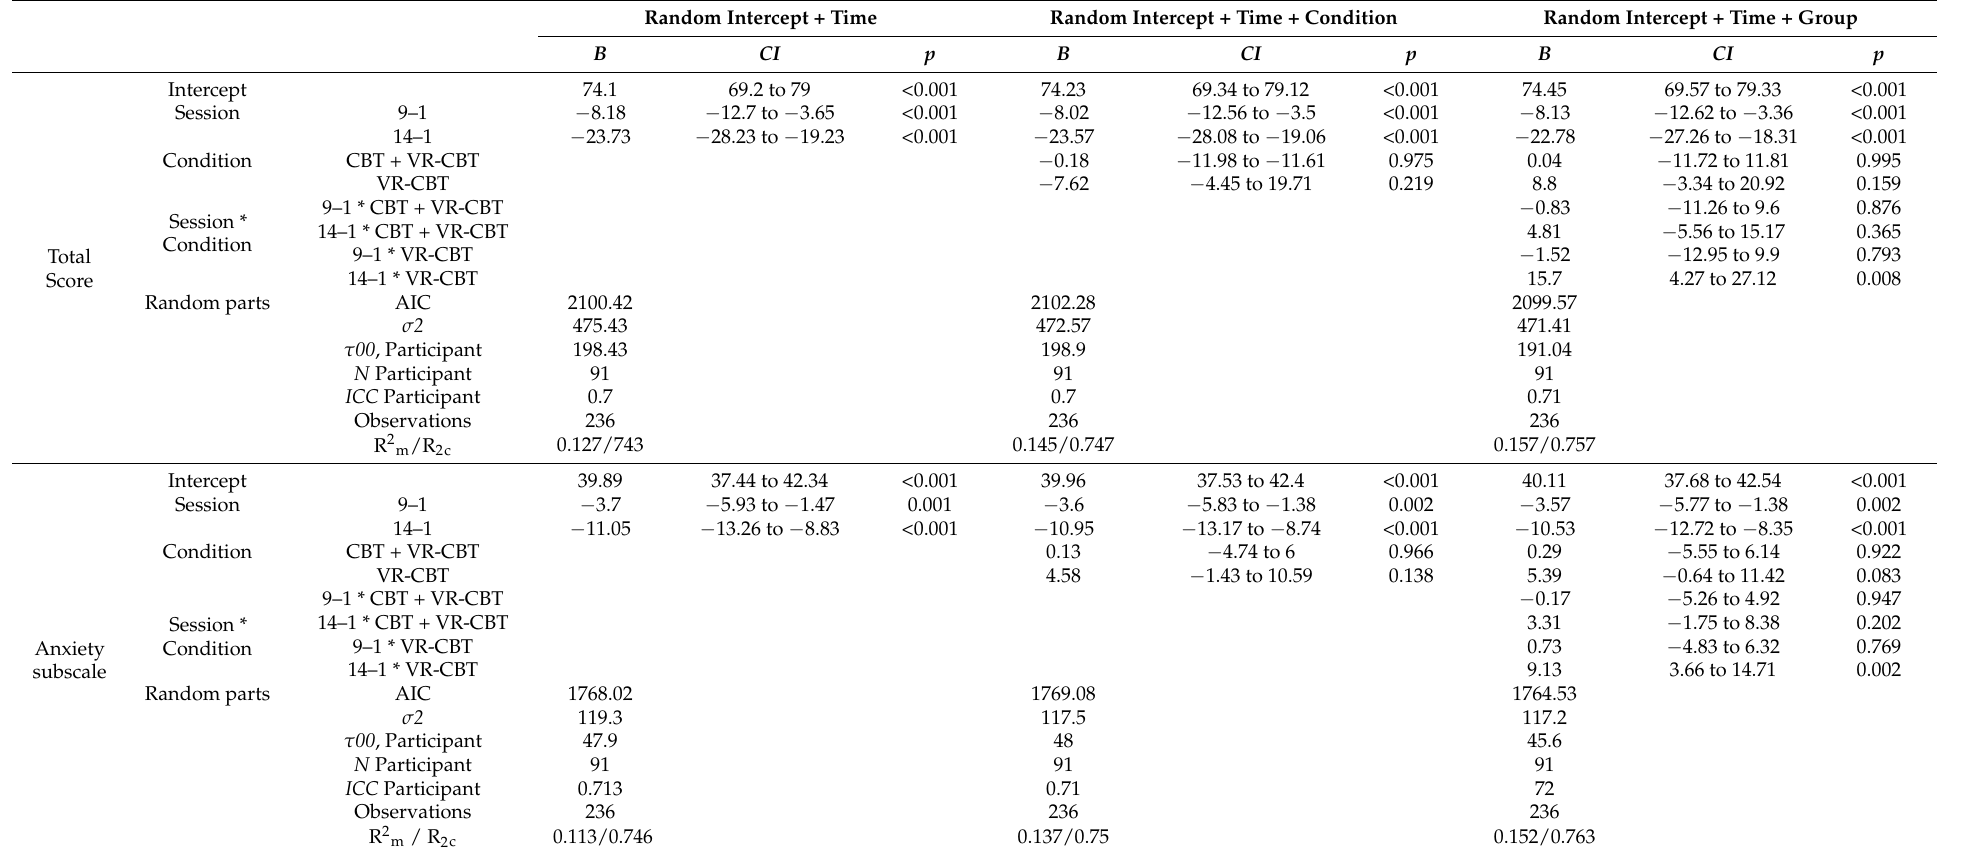
Table 6. Mix model parameters for the Liebowitz Social Anxiety